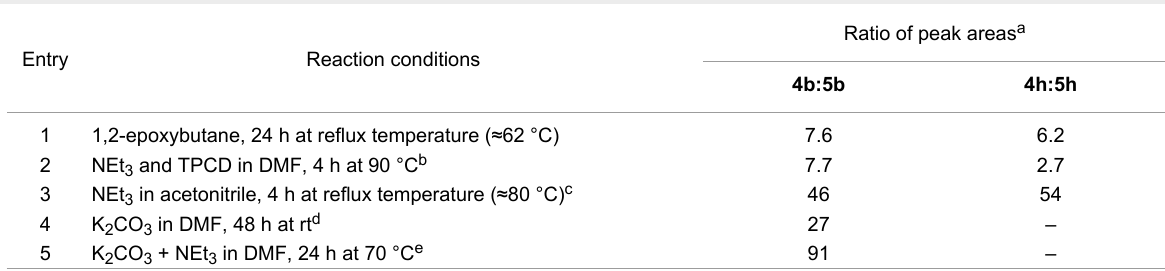
Table 2: The influence of the reaction conditions on the final reaction products.